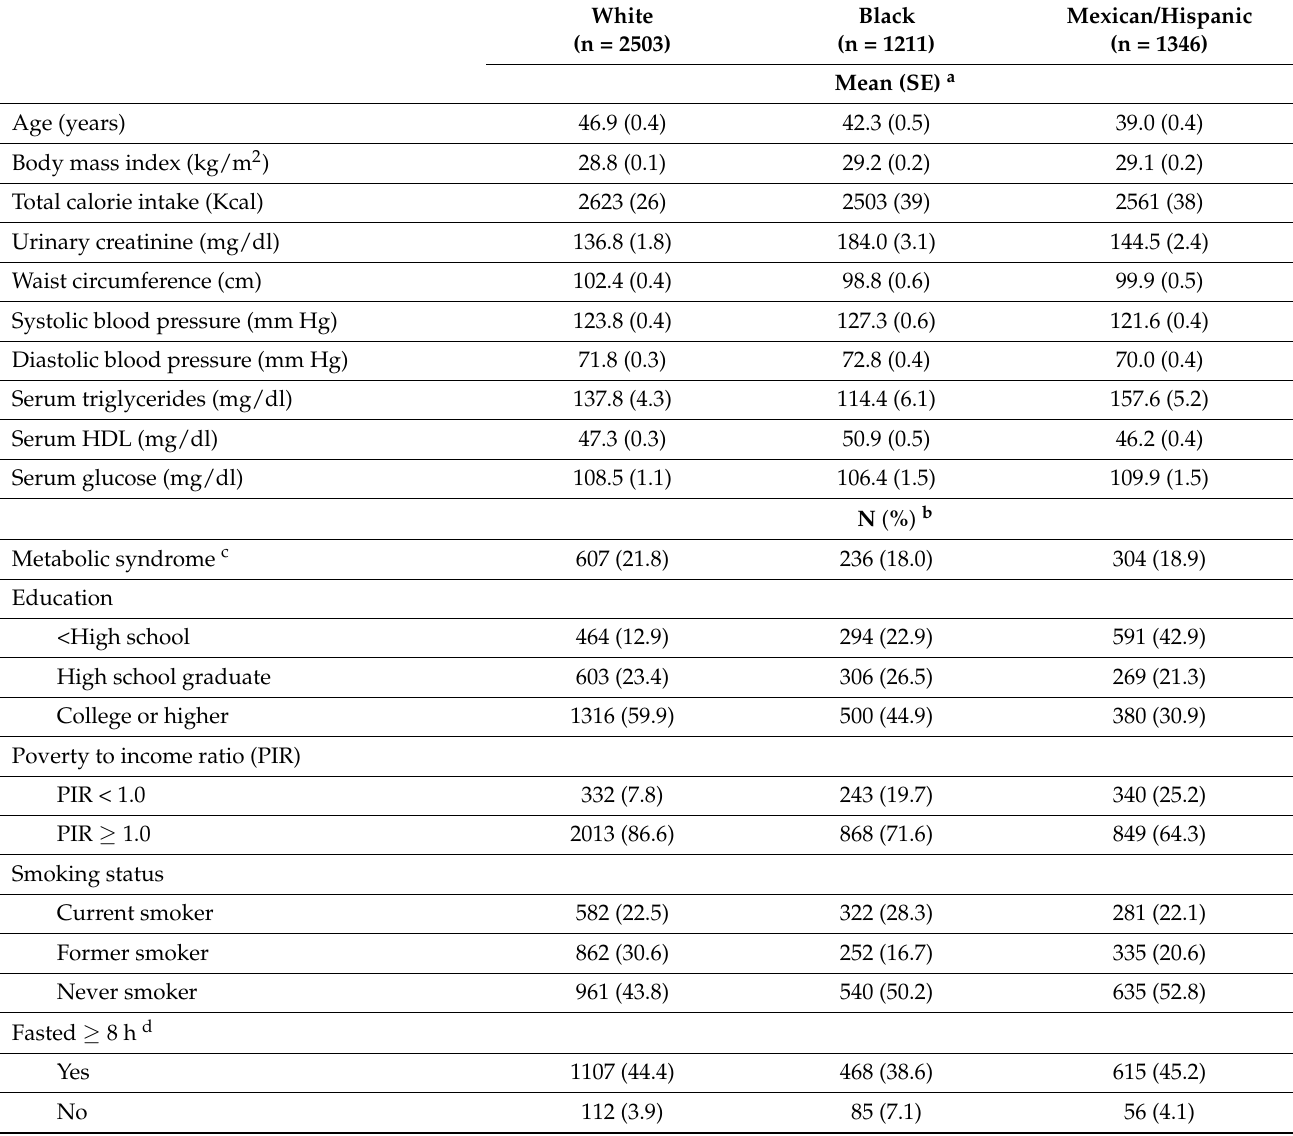
Table 1. Demographic and metabolic characteristics among men, National Health and Nutrition Examination Survey (NHANES)